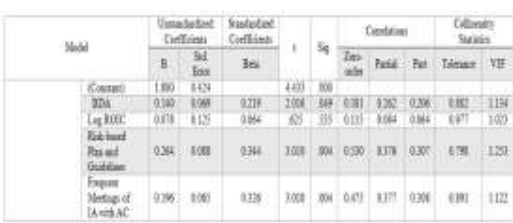
Table 4: Regression